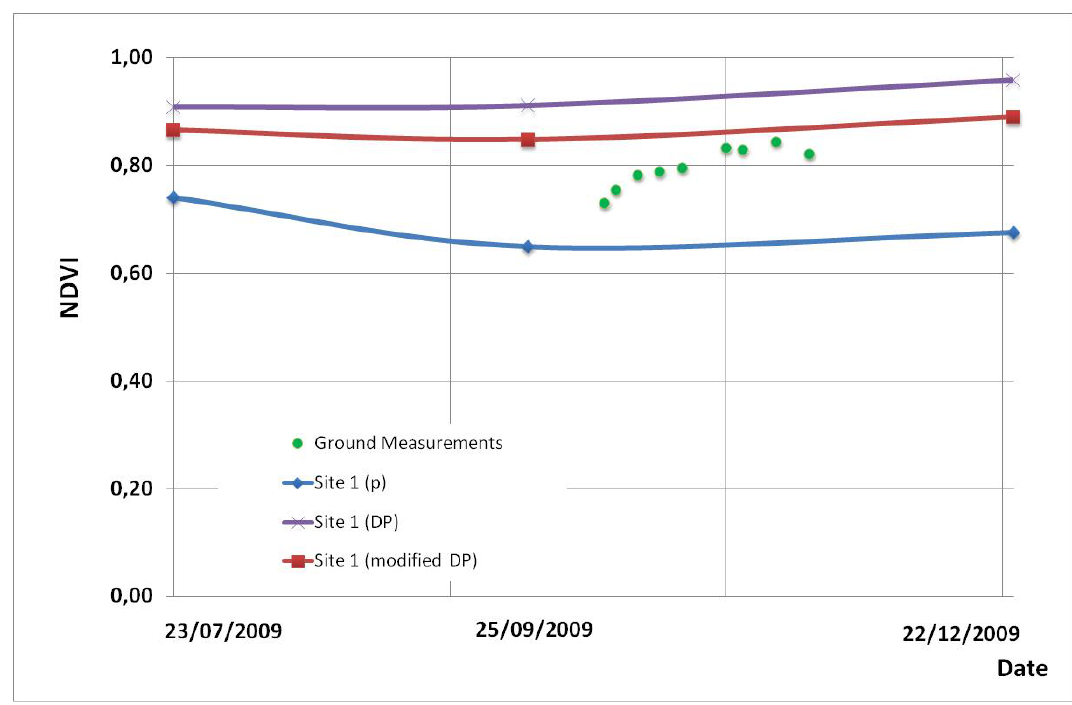
Figure 9. Comparison of NDVI values derived from satellite images (before and after atmospheric correction) and ground spectroradiometric measurements for the agricultural site near Paphos